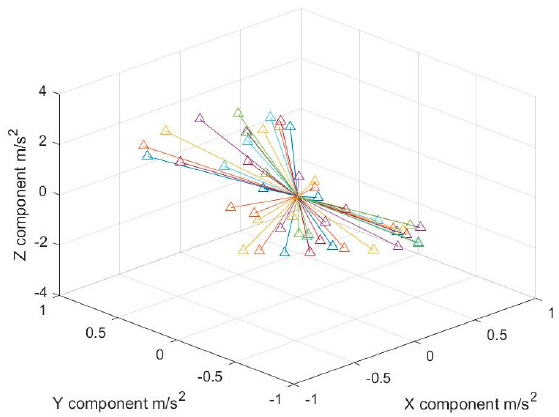
Figure 7. In − step linear accelerations vectors direction.